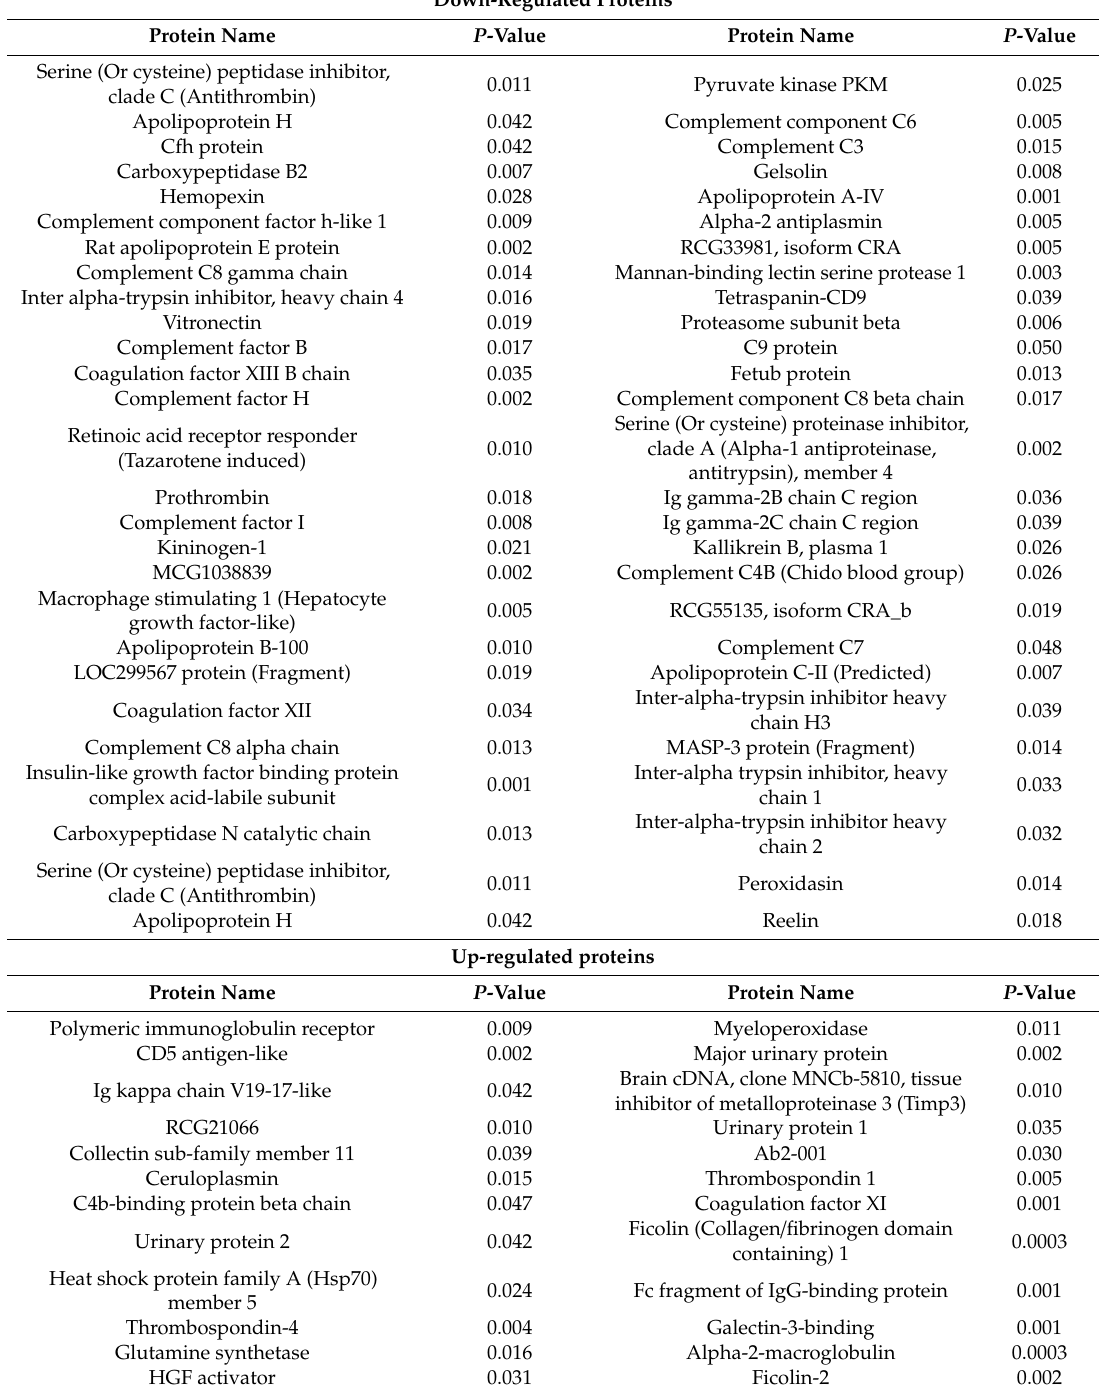
Table 1. List of up-regulated and down-regulated proteins in extracellular vesicles purified from hyperammonemic rats and obtained by SWATH analysis as indicated in